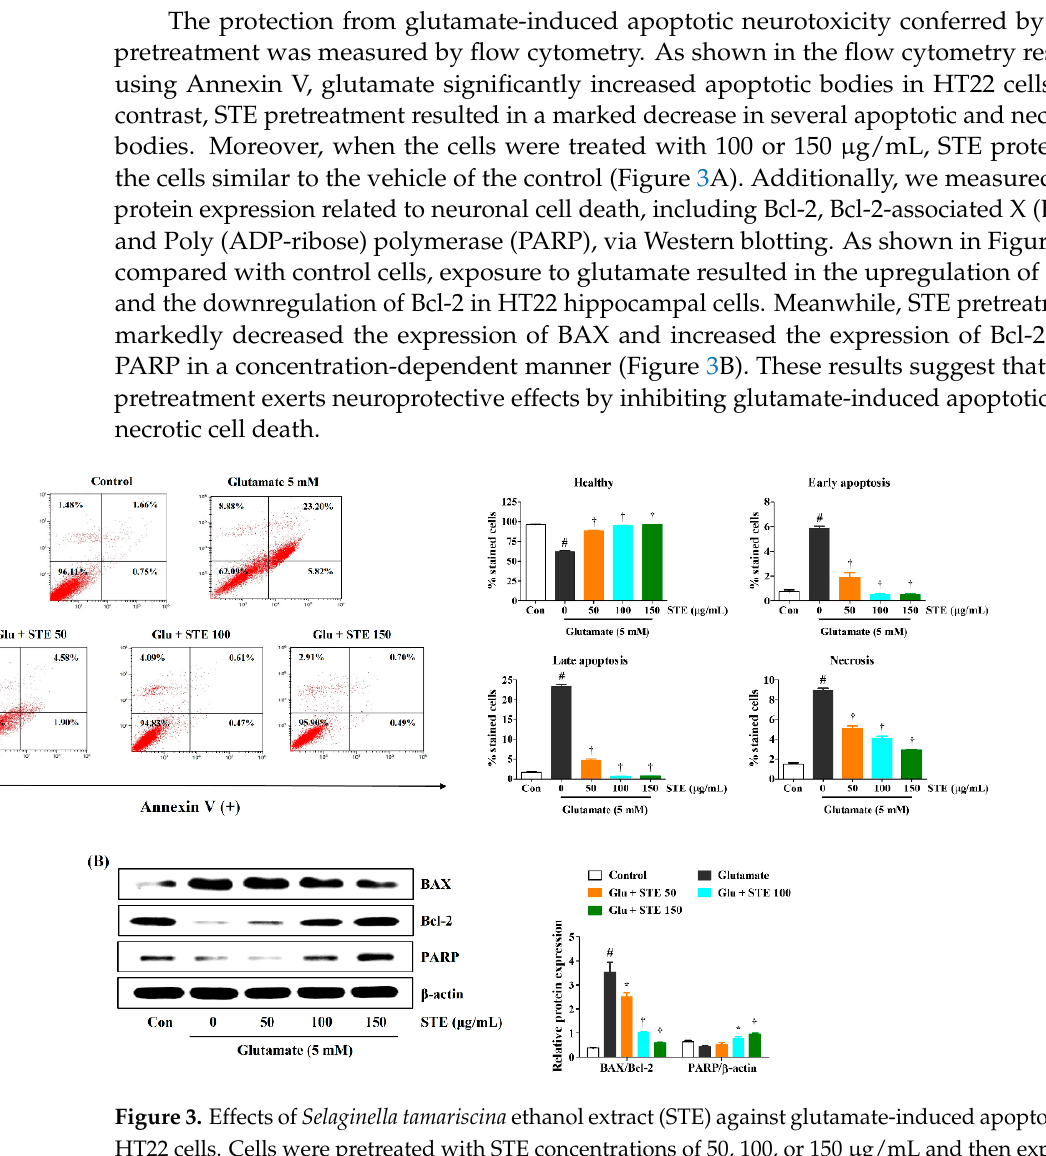
Figure 2. Effects of Selaginella tamariscina ethanol extract (STE) against glutamate-induced intracel- lular reactive oxygen species (ROS) production in HT22 cells. Cells were pretreated with STE con- centrations of 10, 50, 100, or 150 μ g/mL, and then with 5 mM glutamate. H 2 DCFDA (20 μ M), an oxidation-sensitive fluorescence dye, was used to assess the ROS levels. The expression of ROS was determined using a fluorescence microscope and fluorescence microplate reader. Scale bar = 200 μ m. Control cells were incubated with the vehicle alone. All experiments were repeated at least three times, and similar results were obtained. Data are presented as mean ± standard error of the mean. Con, control; Glu, glutamate. Statistical significance was defined as # p < 0.05 (vs. control) and † p < 0.001 (vs. glutamate).